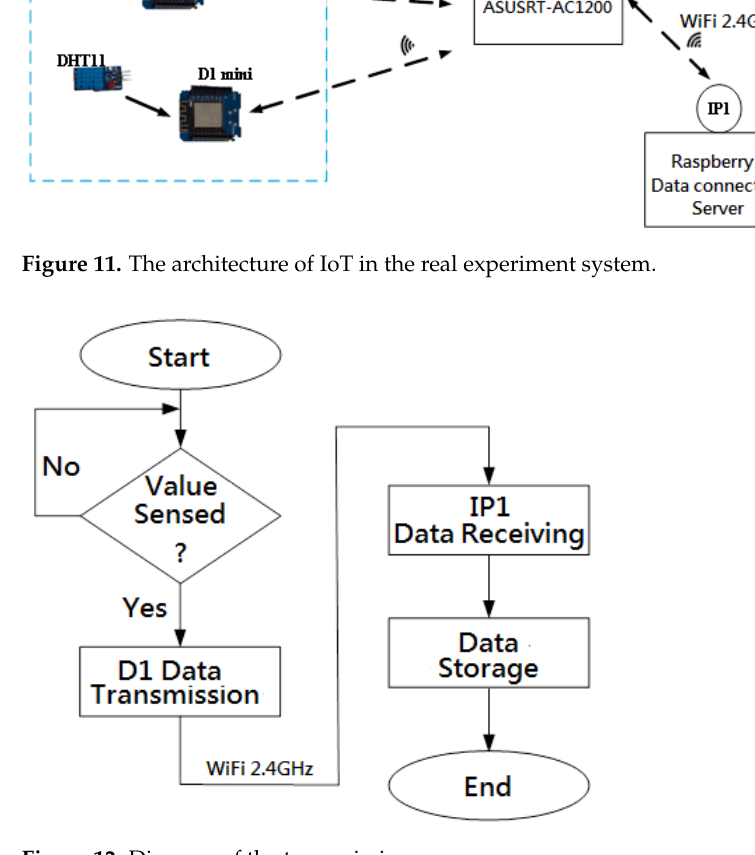
Figure 12. Diagram of the transmission